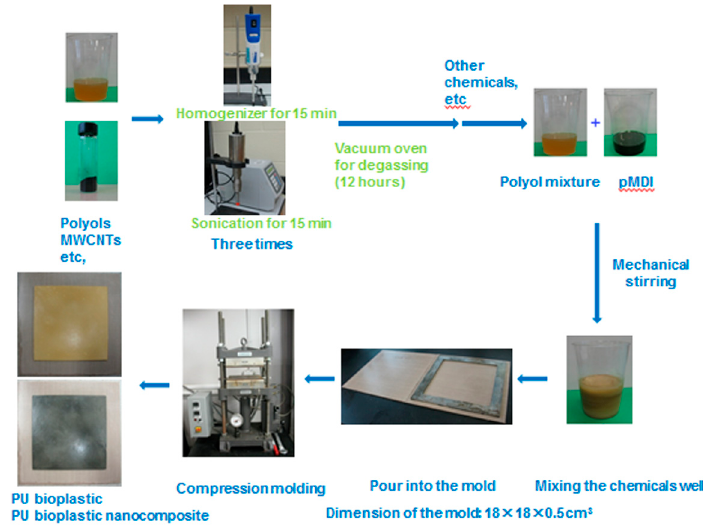
Figure 1. Schematic diagram of preparation of the nanocomposite bioplastics.